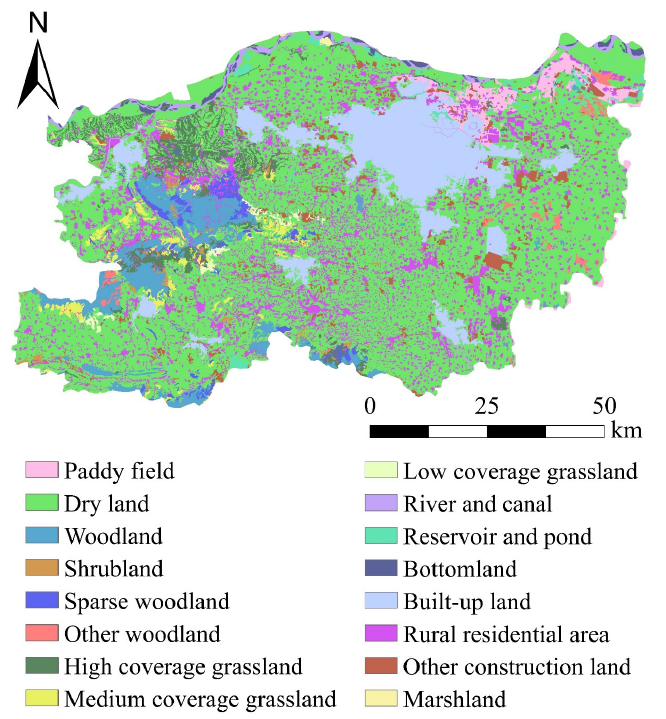
Figure 3. Spatial distribution of LUCC in Zhengzhou in 2020. Table 1. List of variables selection.